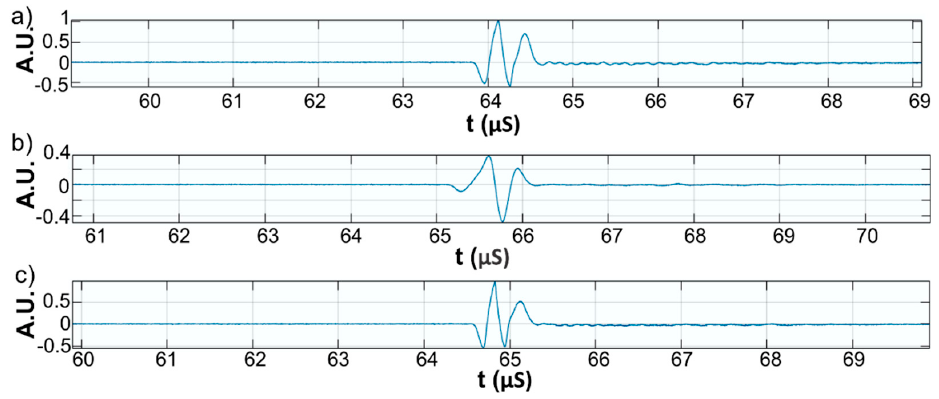
Figure 10. Zoomed first echo for: Wi ( a ); WZn ( b ); and Wd ( c ).